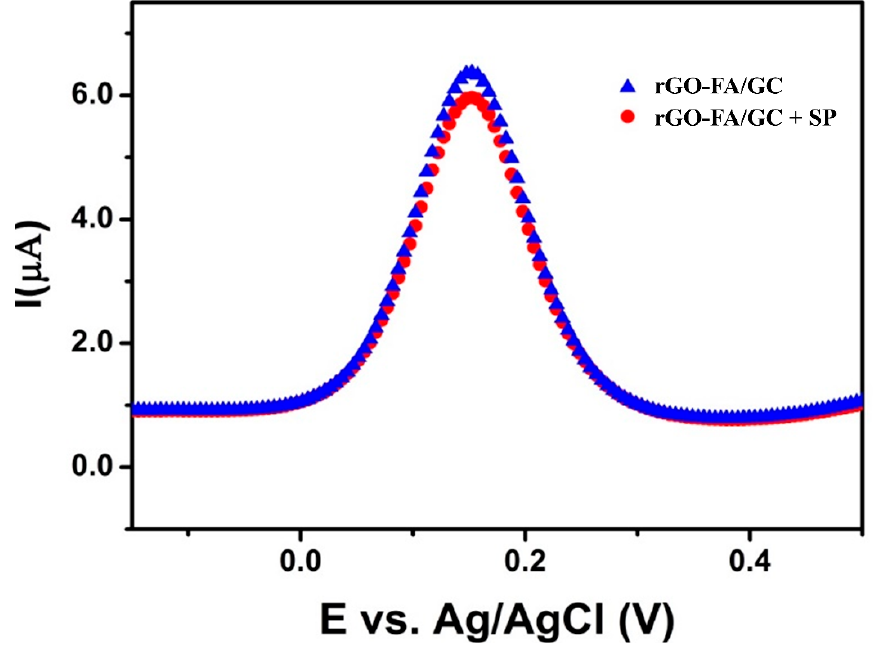
Figure 9. Interference analysis of rGO-FA with the addition of SP/HSA (100 pM) at a scan rate of 50 mV s − 1 . 50 mV s − 1